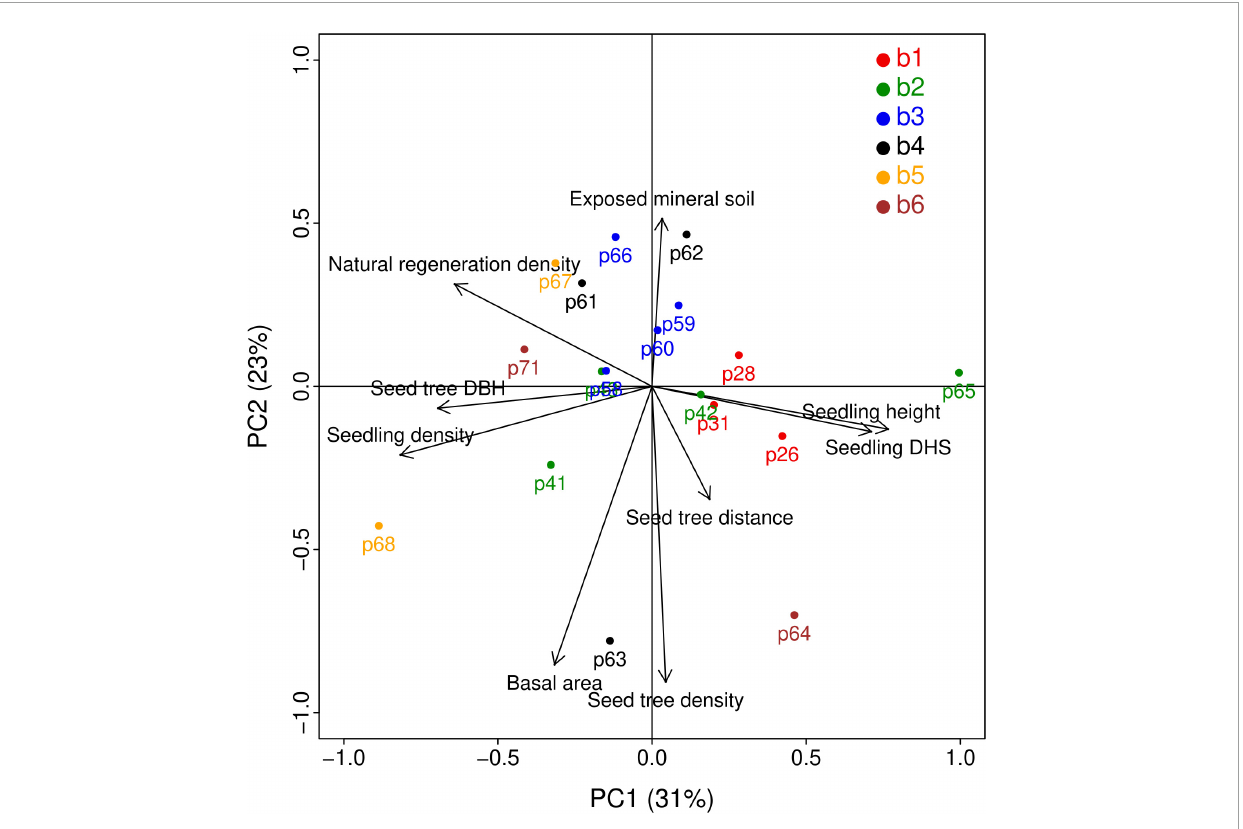
FIGURE3 Projections of the variables (black arrows) and sampling plots (colored dots) on the two main axes of a principal component analysis (PCA). The two main axes explain 31 and 23% of the variation. The variables are: Exposed mineral soil (m 2 ha - 1 ); natural regeneration density (seedlings ha - 1 ); seed tree DBH (cm); seedling density (seedlings m - 2 of exposed mineral soil); basal area (m 2 ha - 1 ); seed tree density (trees ha - 1 ); seed tree distance (m): mean distance of mature trees from the center of the sampling plot; seedling DSH (cm); seedling height (cm). Different colours correspond to different sites (b1 to